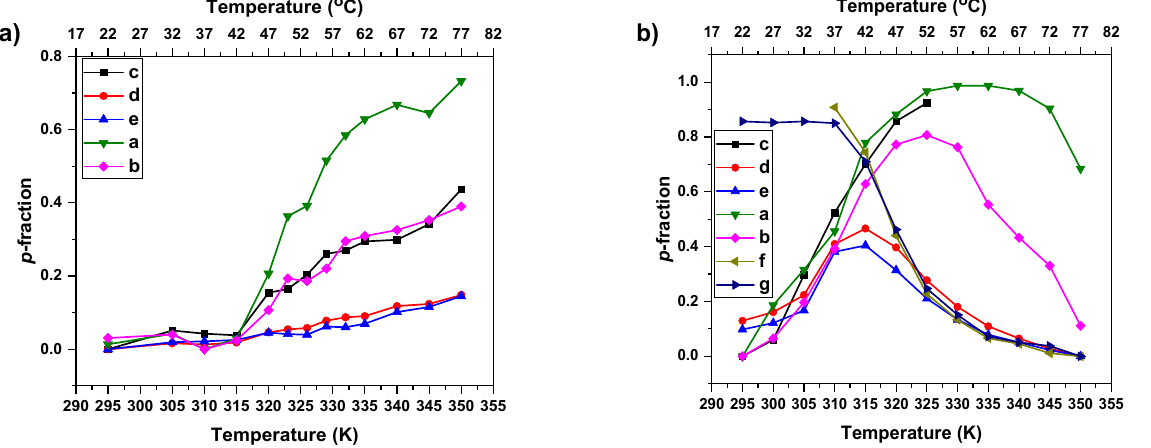
Figure 6. Temperature dependencies of the p - fraction as determined for signals of various proton types in aqueous solutions (c = 2.5 mg · mL − 1 ) of HP ( a ) and BC2 ( b ) during gradual heating.